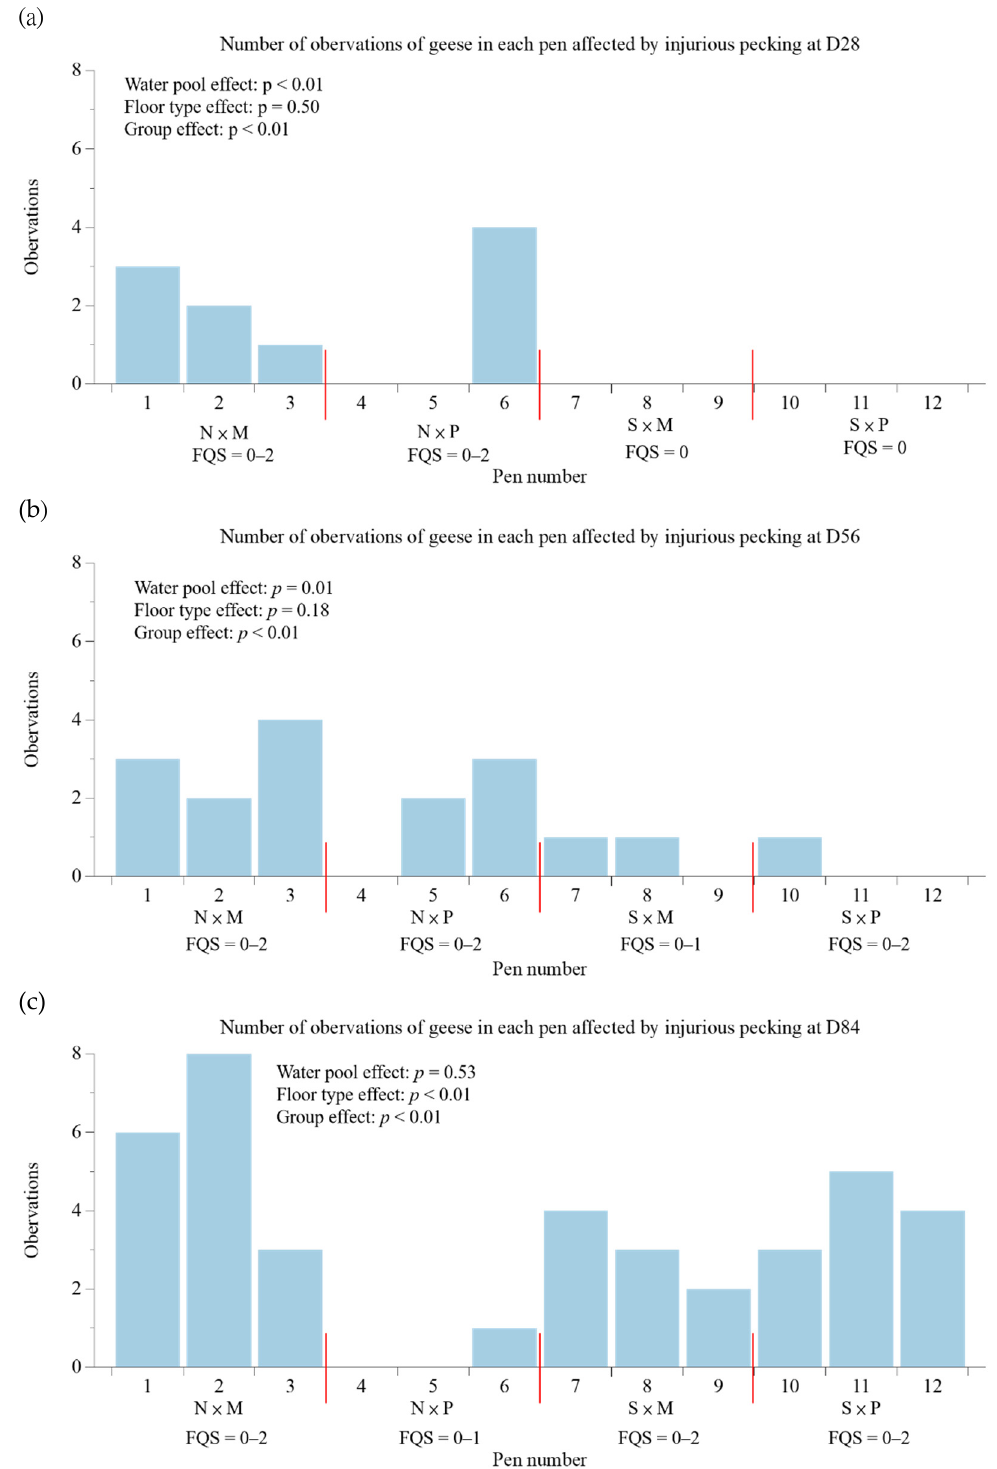
Figure 3. Effects of different swimming pool conditions and floor types on the number of geese affected by injurious pecking in each pen and the feather quality score (FQS) at the age of 28 ( a ), 56 ( b ), and 84 ( c ) days (n = 3). The number indicated under the X axis represents the pen number. N × M = no swimming pool and mud floor; N × P = no swimming pool and perforated plastic floor; S × M = with swimming pool and mud floor; S × P = with swimming pool and perforated plastic floor.